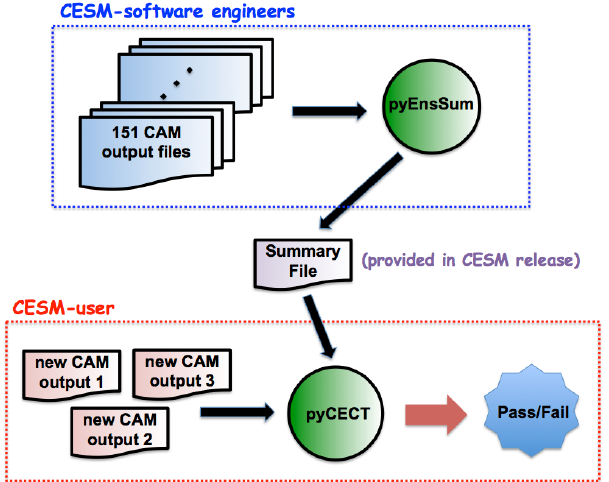
Figure 2. Graphic of CESM-ECT software tools (circles) and work-